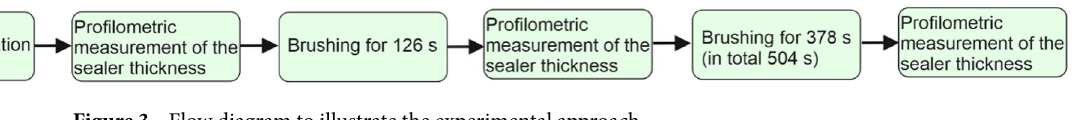
Figure 3. Flow diagram to illustrate the experimental